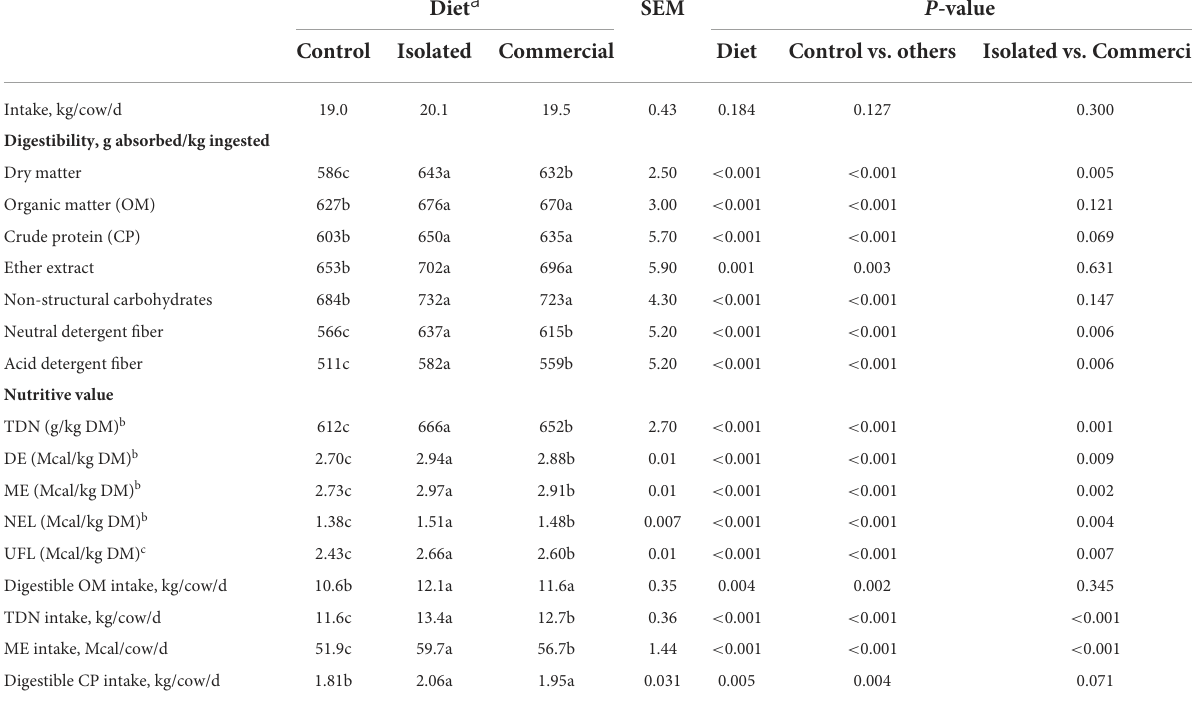
TABLE 3 Experiment 2: Intake, nutrient digestibility and nutritive value of diet supplemented with isolated and commercial E. faecium as probiotics and fed to lactating Holstein cows. Diet a SEM P -value Control Isolated Commercial Diet Control vs. others Isolated vs. Commercial Intake, kg/cow/d